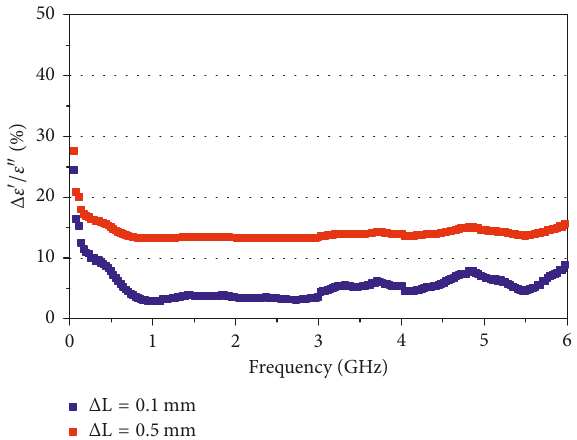
Figure 2: Relative uncertainty in ε is the result of a permittivity measurement of a 4mm where ε R length sample of APU10 (solid magnetic material presented in ′